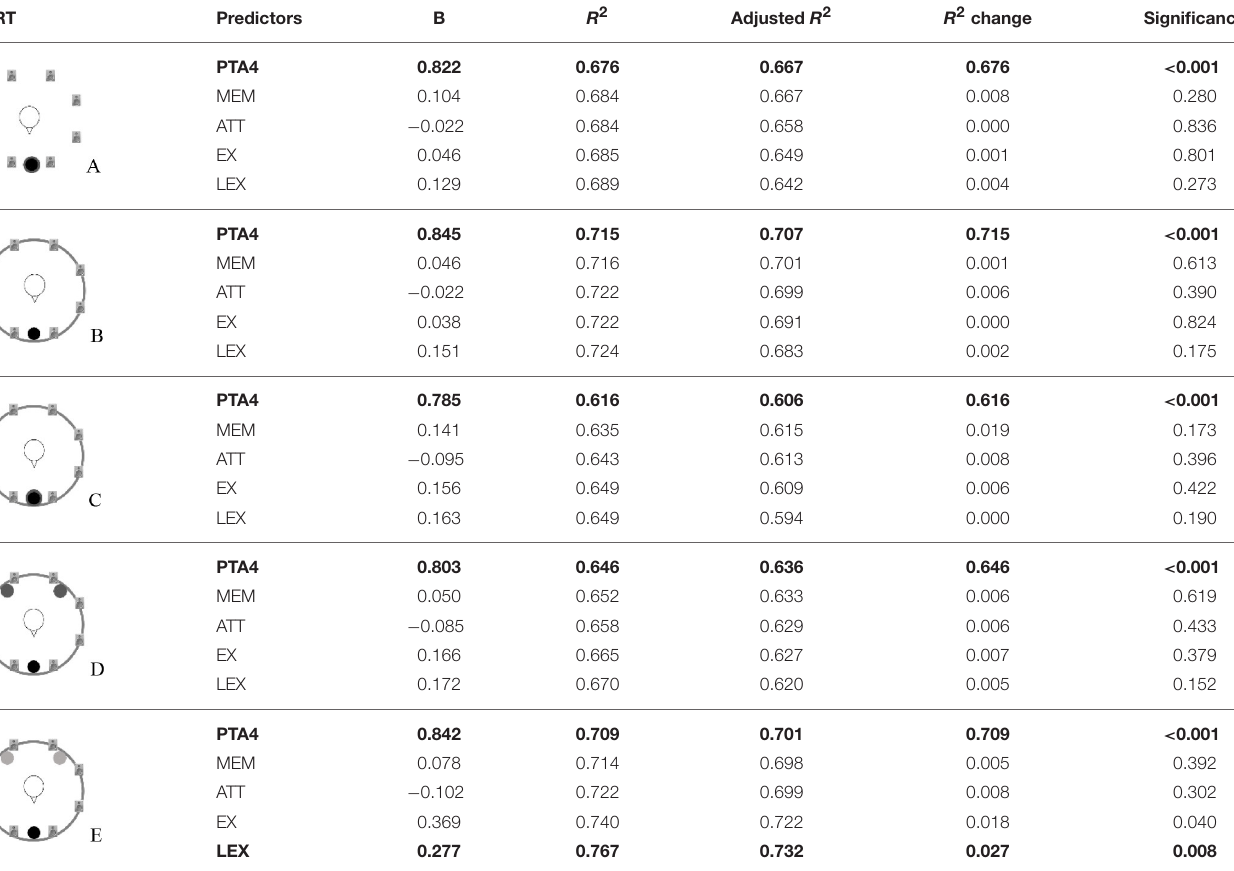
TABLE 4 | Results of the stepwise regression analyses for the data of all participants ( N = 41) calculated for each listening condition (A–E).